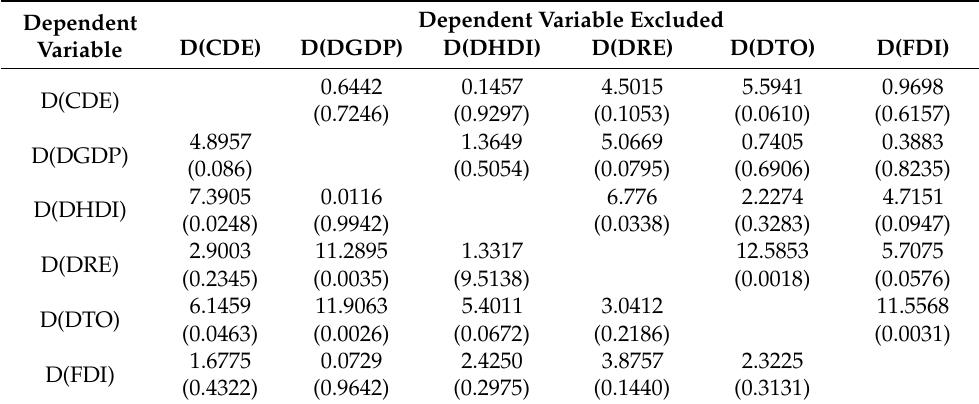
Table 9. The result of VAR Granger Causality/Block Exogeneity Wald Test.